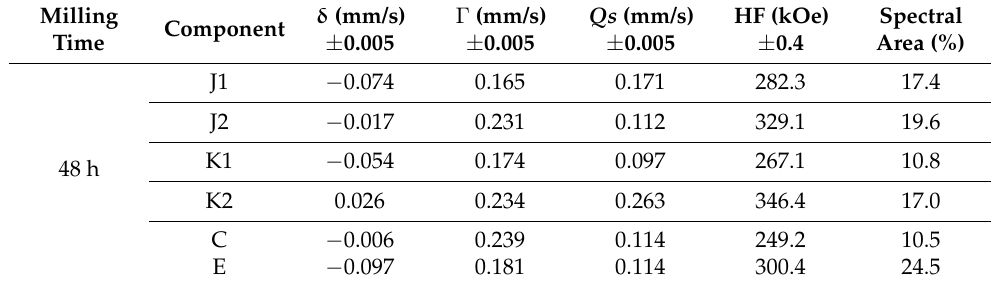
Table 6. Extrinsic magnetic properties of the Nd 2 Fe 14 B system and milled for 24 and 48 h with oleic acid as surfactant.